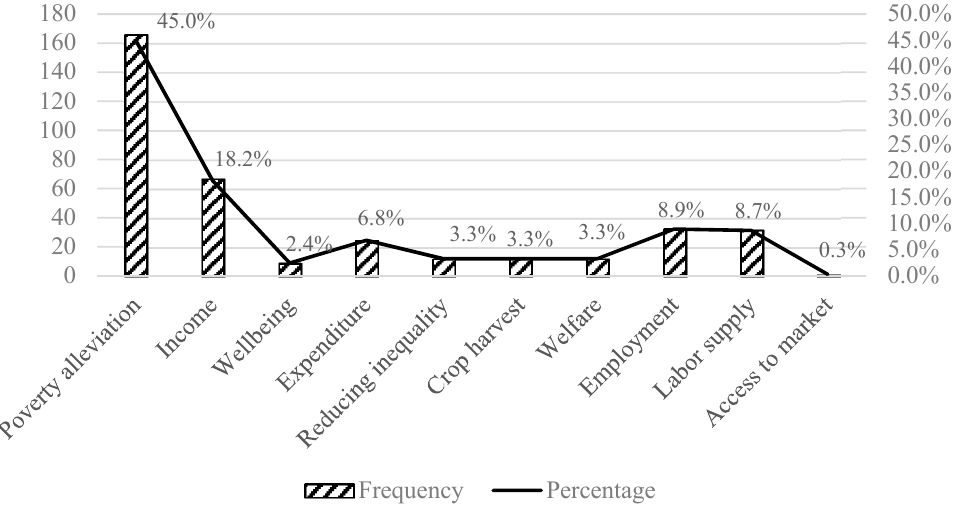
Figure 1. Evaluation indicator distribution of the social e ff ects of protected areas by number and by percentage.